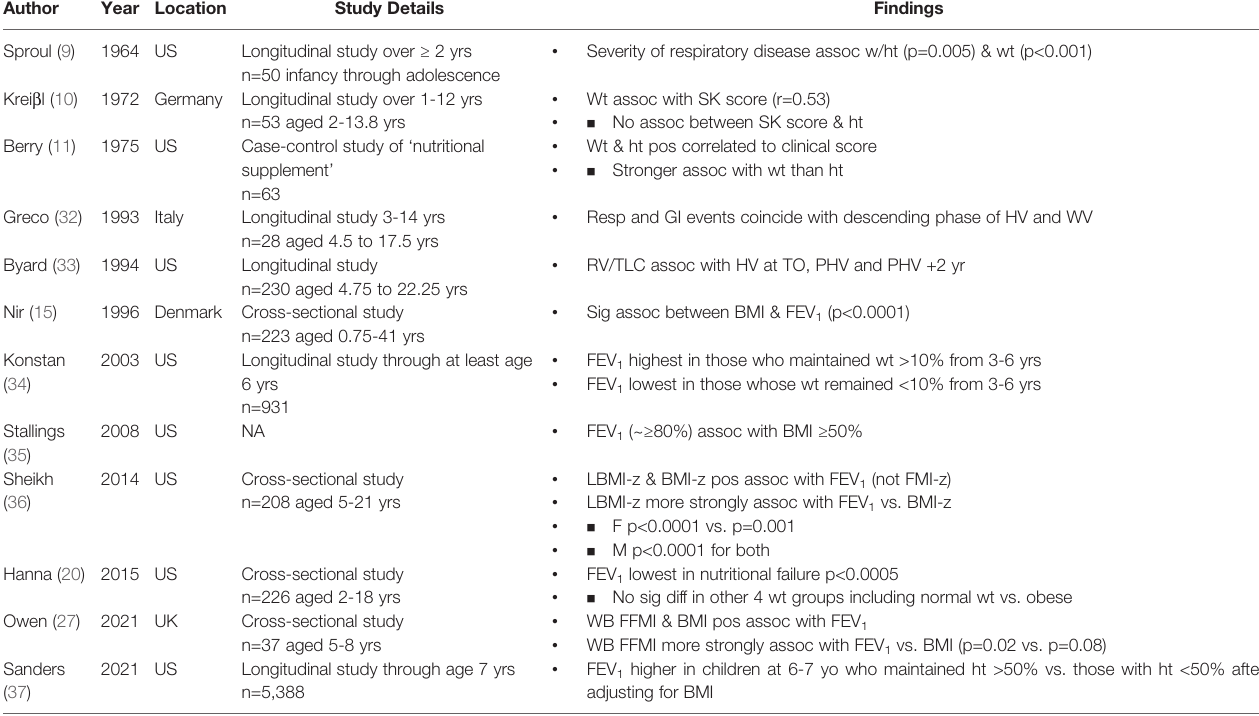
TABLE 2 | Relationship between Growth and Pulmonary